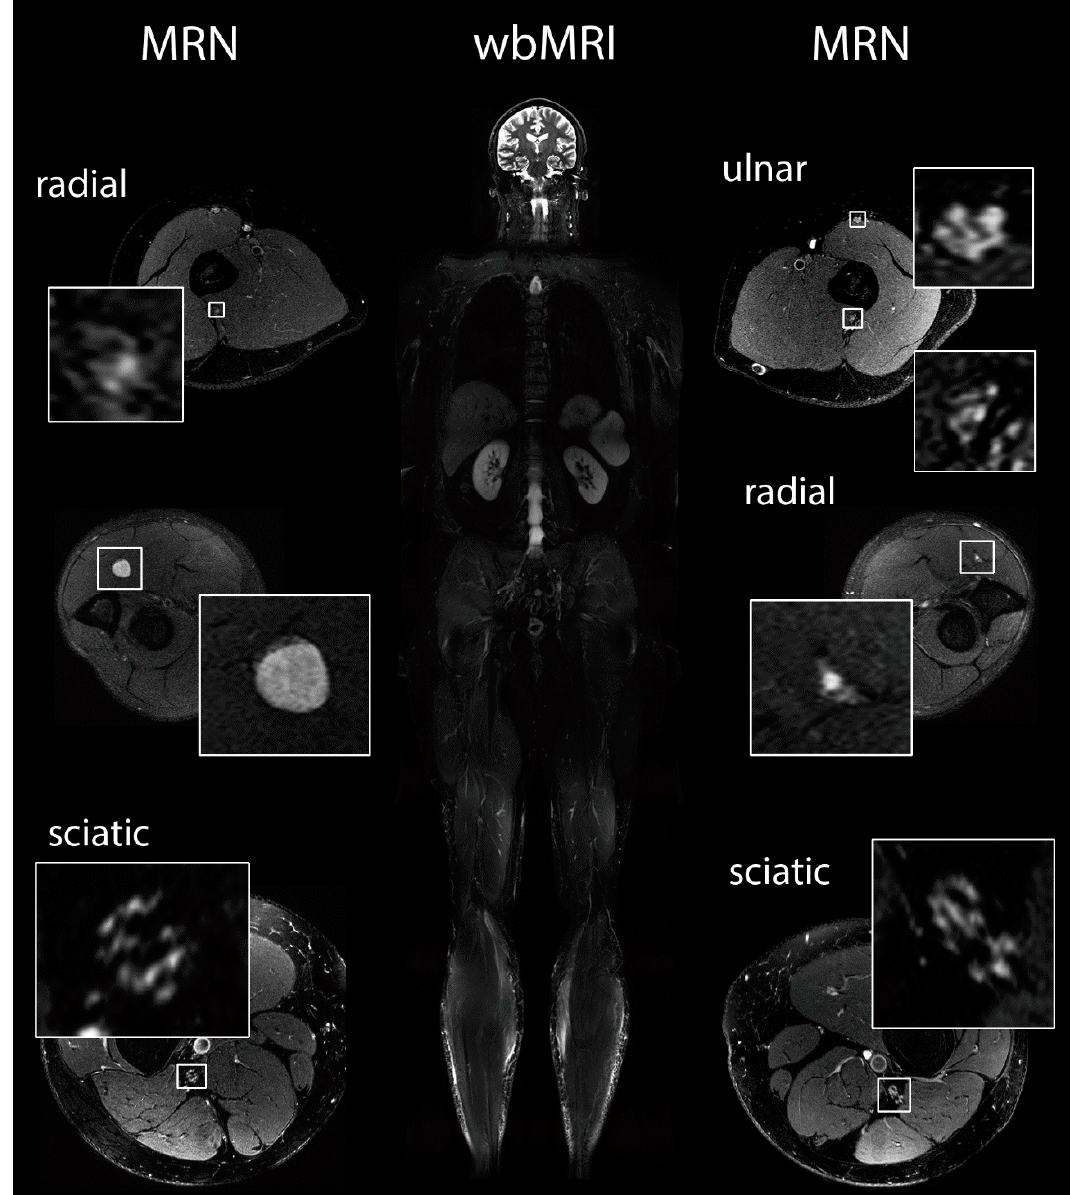
Figure 2. Scheme of imaging strategy. wbMRI and MRN protocols were performed for comprehensive imaging evaluation. wbMRI (middle column) was used for detection of large tumors. MRN (left and right columns) was used for detection of smaller nerve lesions. In this patient, fascicular nerve lesions are present in all nerves, while a larger tumor is shown in the right radial and an intermediate-sized nodule in the left radial nerve MRN indicated abnormalities in larger peripheral nerves (lumbosacral plexus, sciatic nerve, tibial, nerve, peroneal nerve, sural nerve) in 16 of 18 patients. These abnormalities ranged from small T2-weighted lesions of individual fascicles without caliber increase to large compressive schwannoma formations. Larger intraneural macrolesions or intermediate-sized nerve nodules were detected in MRN scans of 10 of 18 patients (Figure 3). In six patients, only fascicular nerve microlesions of less than 5 mm in diameter were observed. Two patients had no detectable nerve lesions on MRN scans at all.